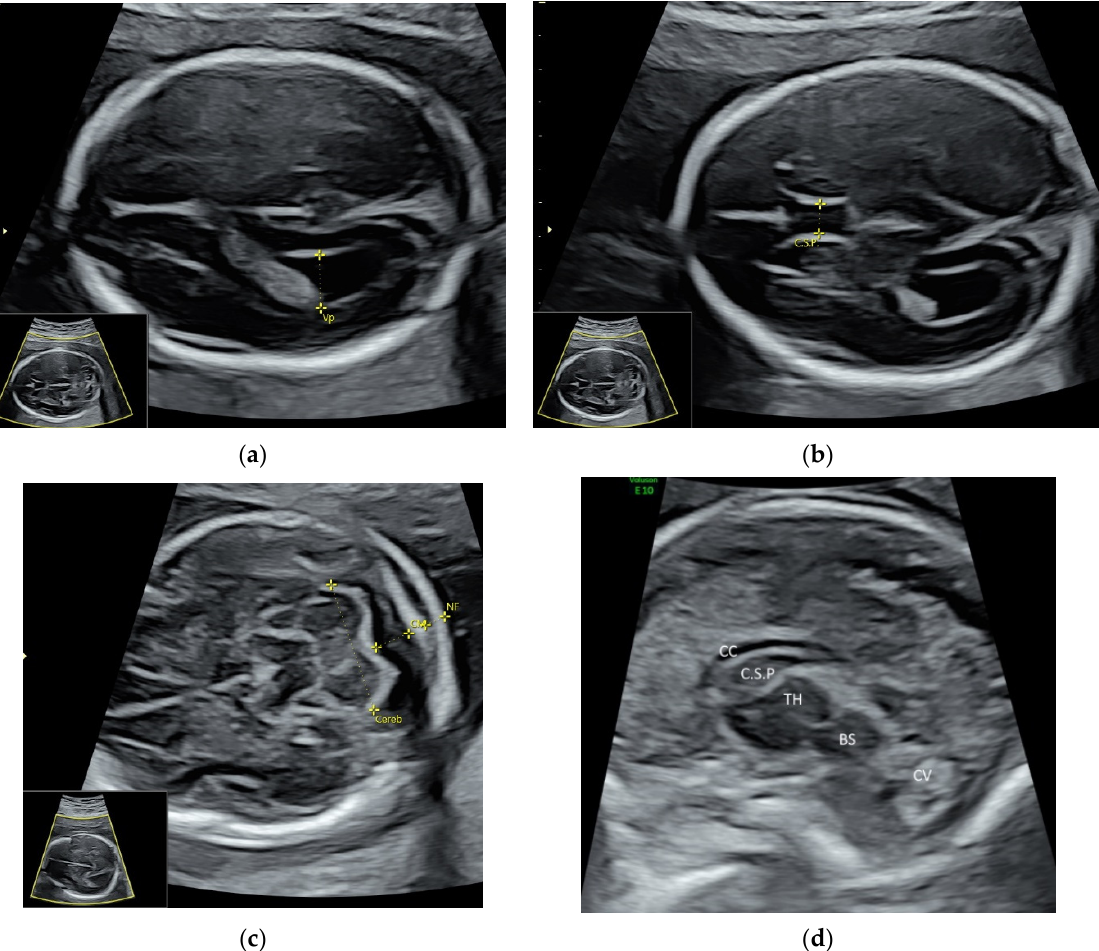
Figure 2. High-resolution ultrasonography of the fetal brain at 20 weeks’ gestation: transverse views showing ( a ) posterior horn of the lateral ventricle (Vp), ( b ) cavum septi pellucidi (C.S.P.), ( c ) cerebellum (Cereb), Cisterna magna (CM), nuchal fold (NF), and sagittal view showing ( d ) corpus callosum (CC), thalamus (TH), brain stem (BS), and cerebellar vermis (CV).